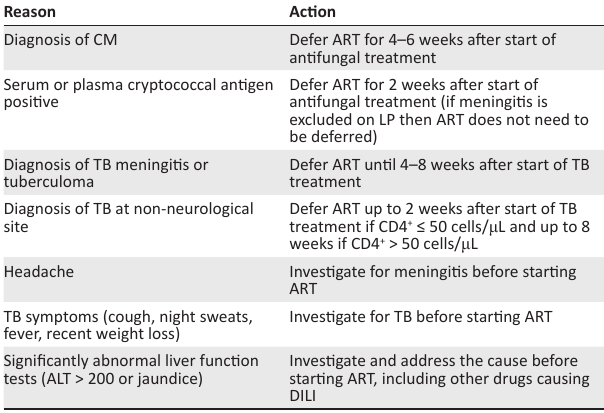
TABLE 3: Medical reasons to defer initiation of antiretroviral